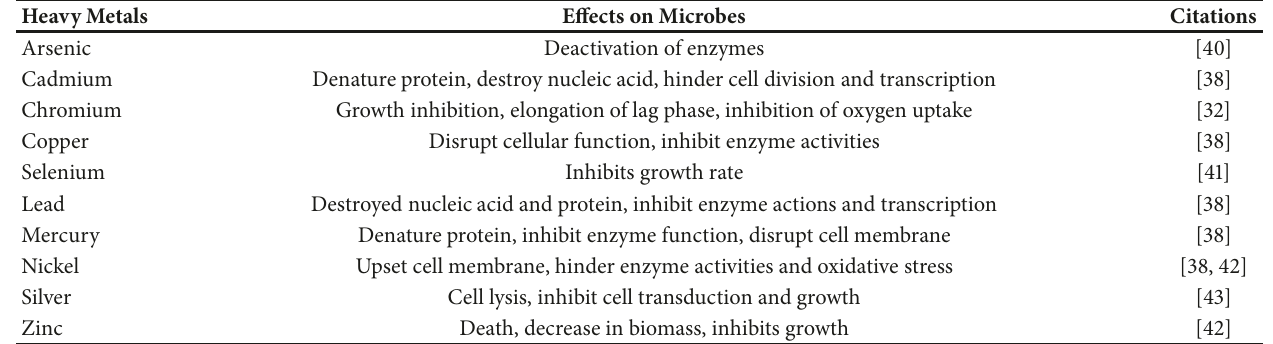
Table 1: Toxicity of heavy metals to microorganisms.